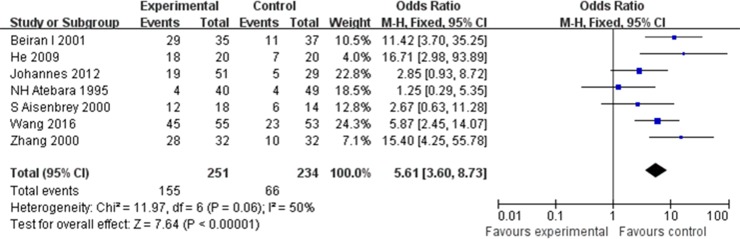
Forest plots for overall analyses: Oxygen therapy vs Control, outcome: Visual acuity.